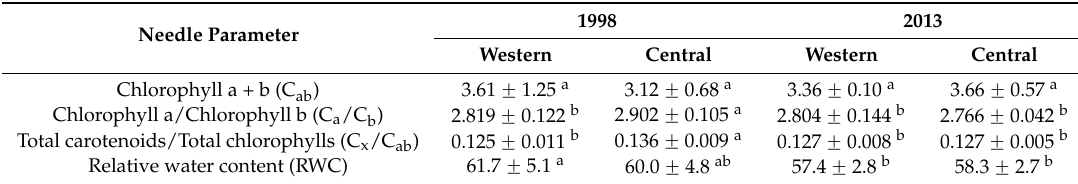
Table 4. Mean ˘ standard deviation of the chlorophyll a + b (mg ¨ g ´ 1 ), pigments ratios, and relative water content (%) in the Norway spruce needles collected at the western and central Ore Mountains sites in 1998 and 2013. Different letters (a, b) indicate significant difference between year and site combinations according to the performed Tukey-Kramer test ( α = 0.05).